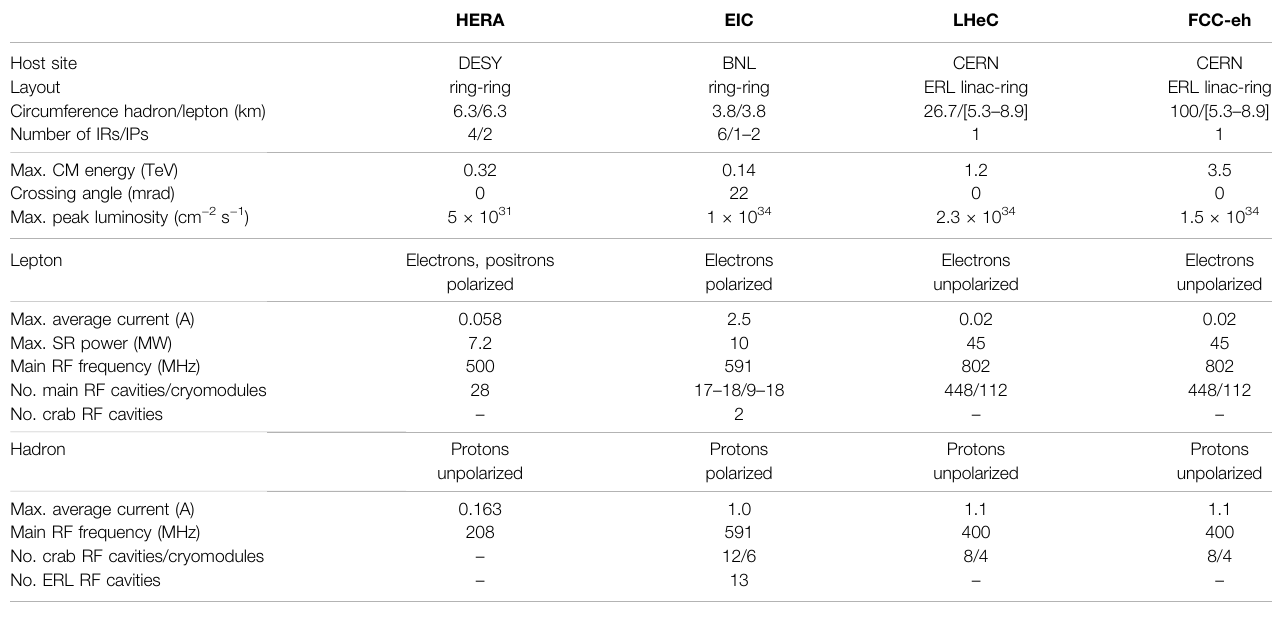
TABLE 2| Parametercomparison forpastanddesignedelectron-hadroncolliders.TheEIC,LHeCandFCC-ehalsoincludeanelectron-ion program.Additionalparameters can be found in Refs. 5, 8, 58, and 73.